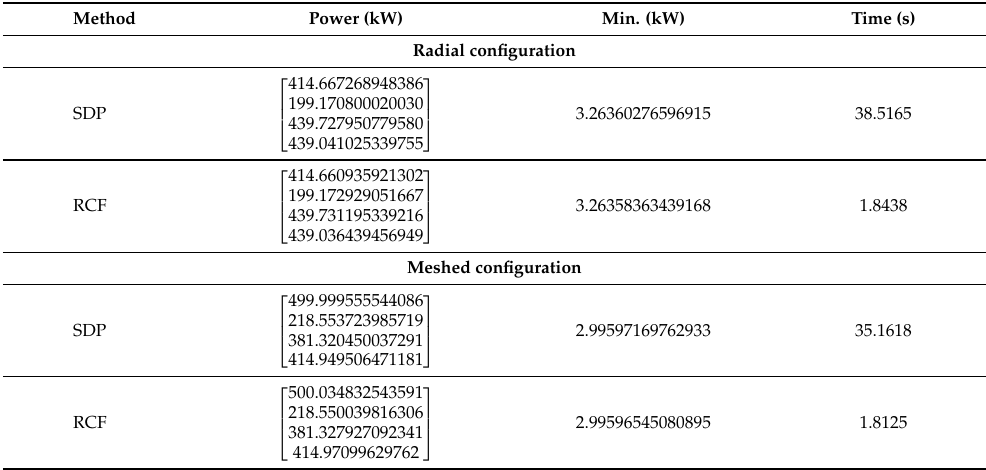
Table 4. OPF solution for the 85 bus with radial and meshed configurations using the proposed RCF and the SDP method.